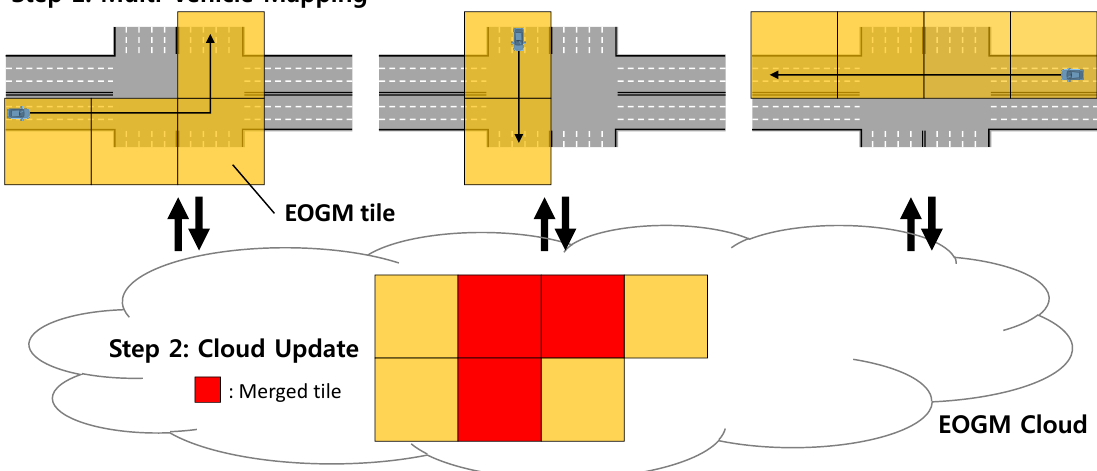
Figure 1. Two-step framework for EOGM cloud update of multi-vehicle